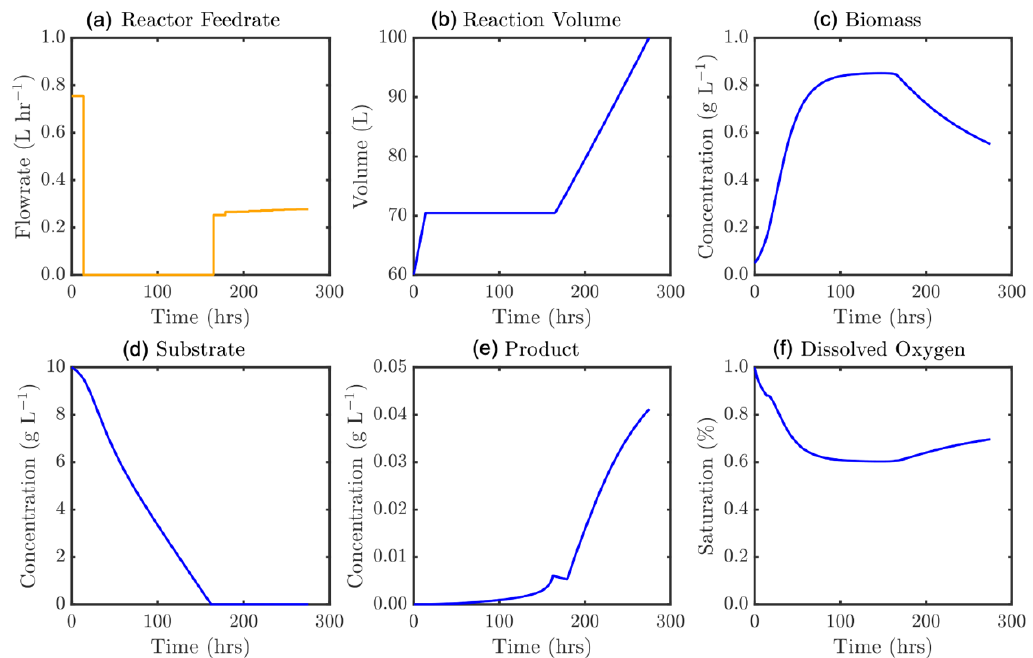
Figure 13. Optimal feedrate profile ( a ) and corresponding model states, ε = 205 h: ( b ) culture volume, and concentrations of ( c ) biomass, ( d ) substrate, ( e ) product, and ( f ) dissolved oxygen.